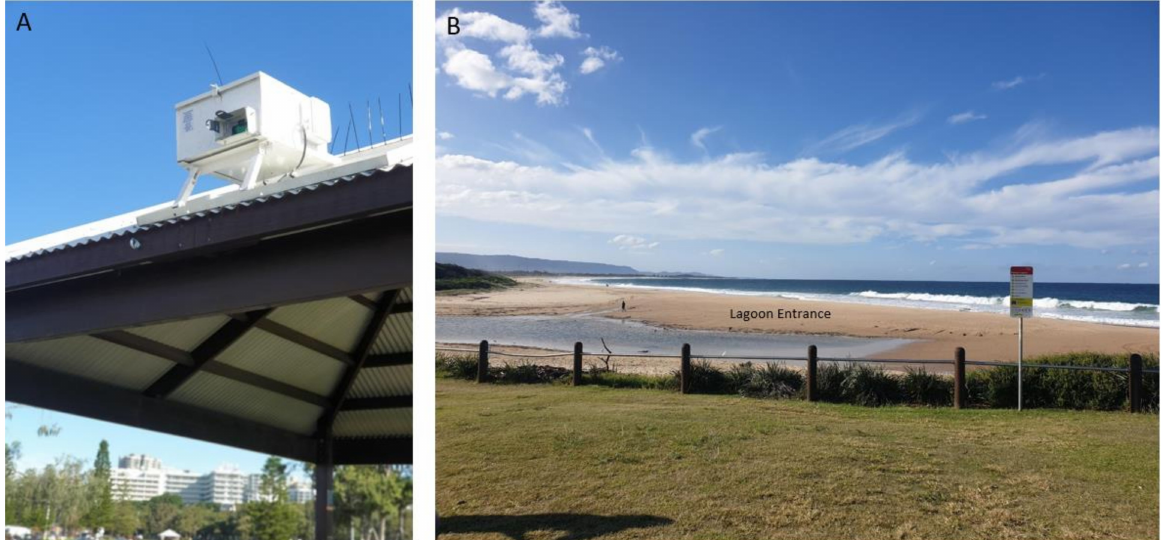
Figure 4. ( A ) Remote monitoring station; ( B ) Field of View from Lidar Sensor. The monitoring station is deployed at the Fairy Lagoon entrance and located